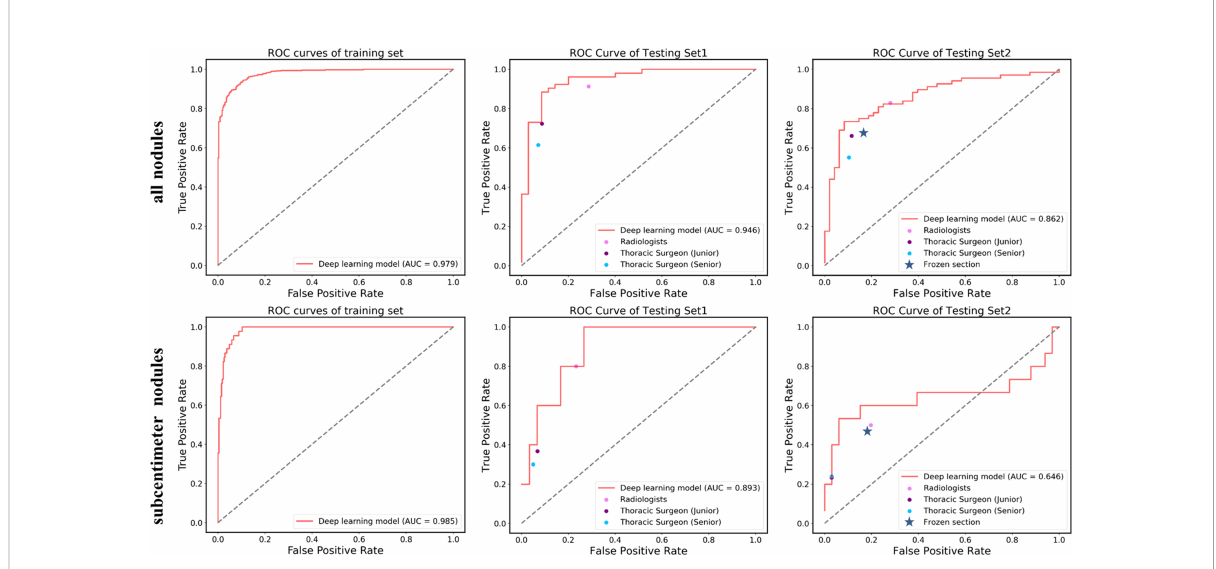
FIGURE 3 ROC curves showing the performance of the deep learning model and current methods in distinguishing pre-IAC from IAC in testing set 1 and testing set 2. Note that the results of frozen sections as well as radiologists and surgeons do not have probabilities and they were shown as line or dots in the fi